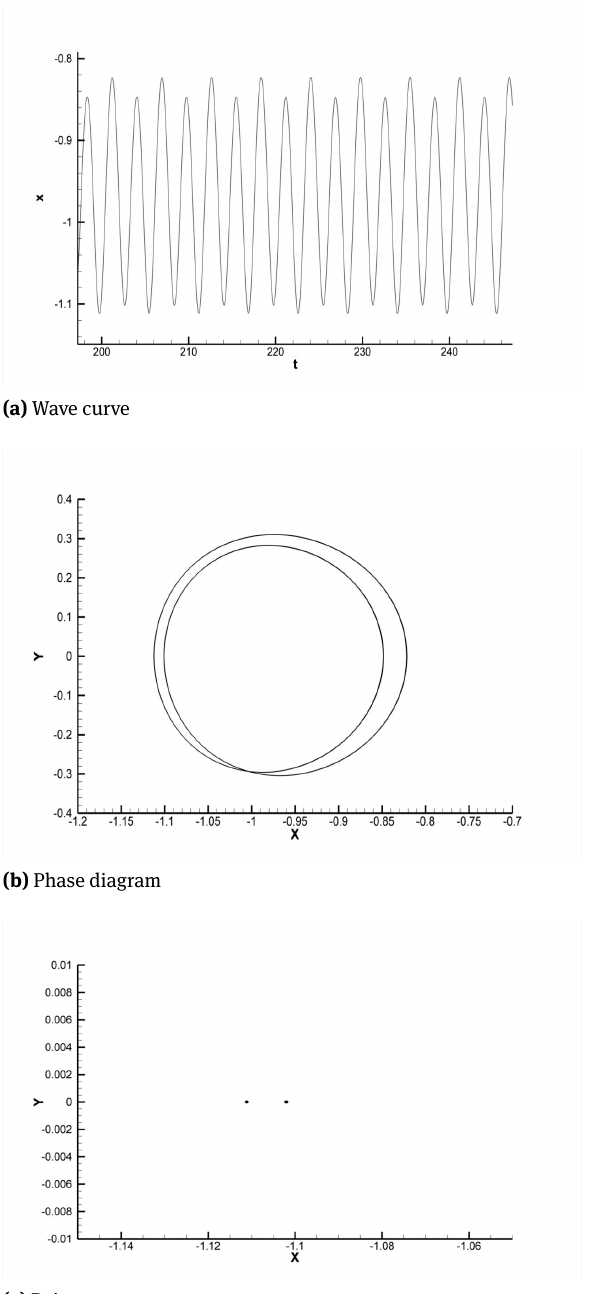
Chaotic Behavior of non-linear system ( r = 0.935, ω = 2.5, k = 0.5, x (0) = −1.0 , ˙ x (0) = −1.0